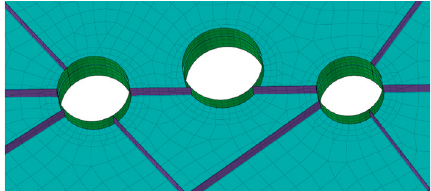
Figure 16: Mesh refinement